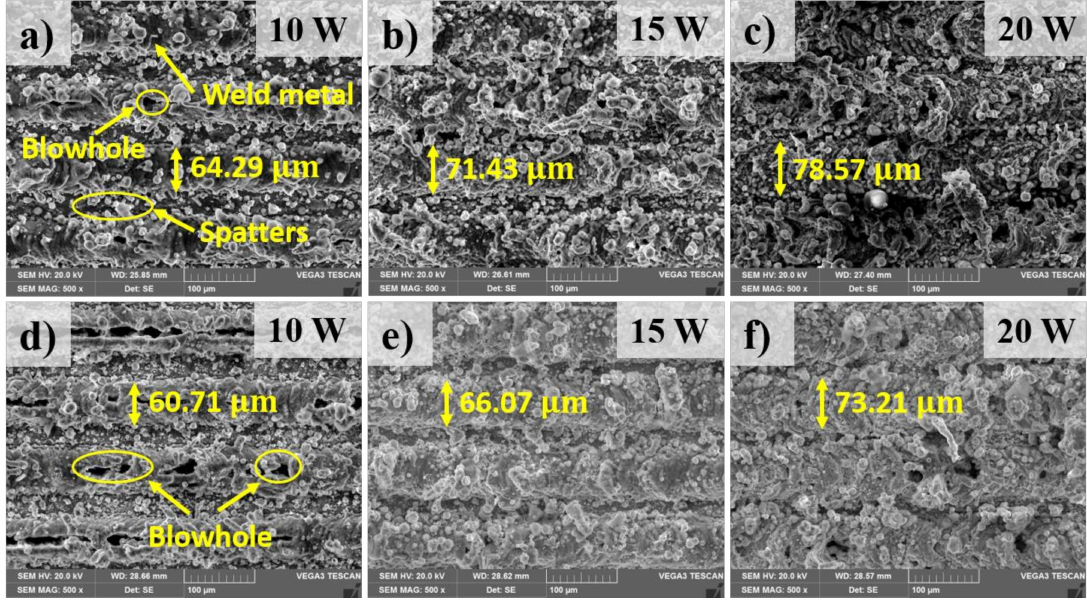
Figure 6. SEM images at the center of the welding zone on the top surface. ( a – c ): Welding without the metal tube; ( d – f ): Welding with the metal